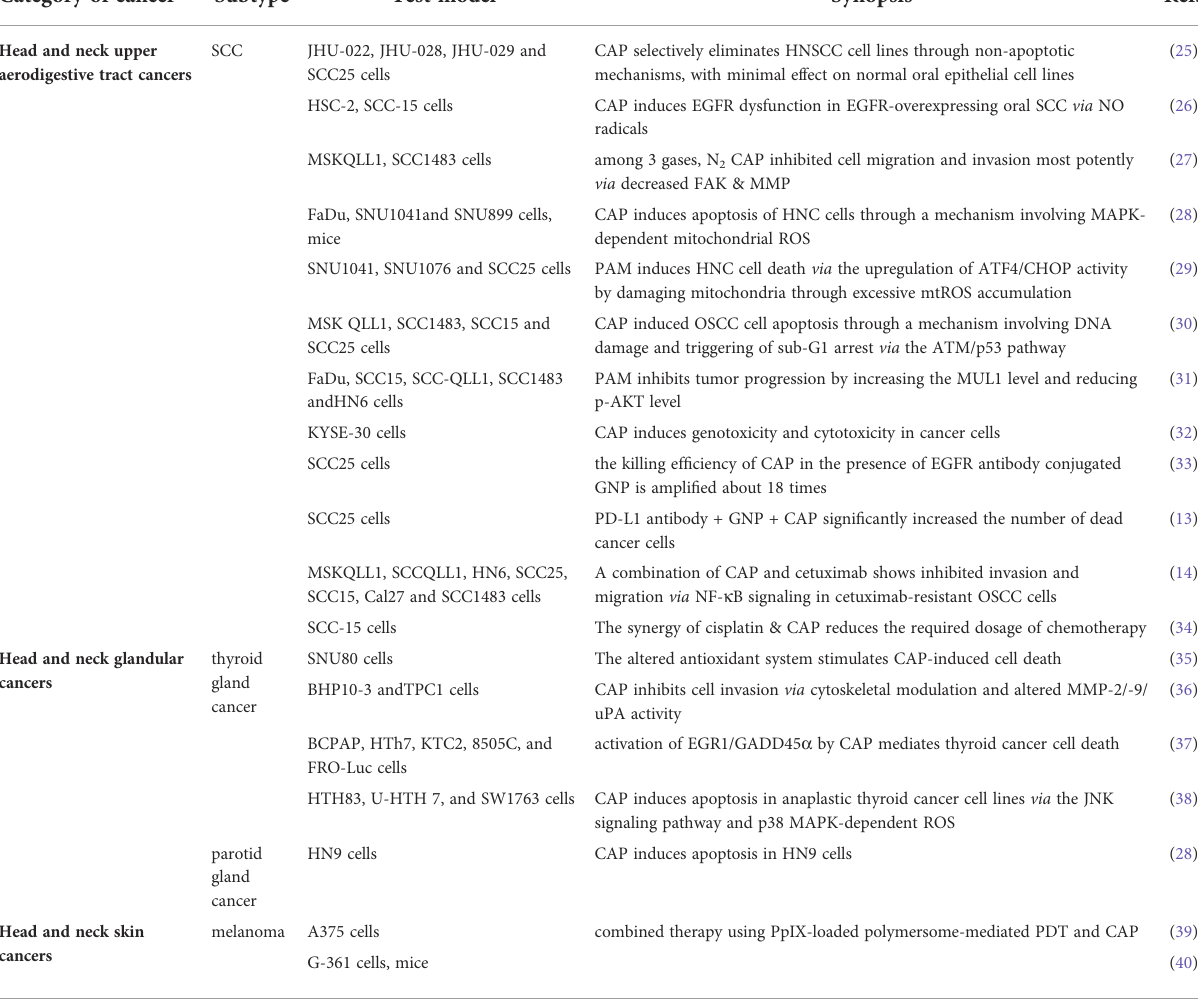
TABLE 2 Overview of studies on CAP treatment in head and neck